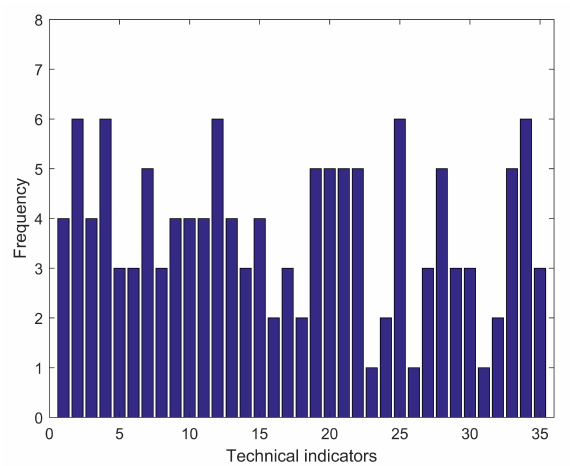
Figure 4. Histogram of the technical indicators appearance in the output of the proposed algorithm.